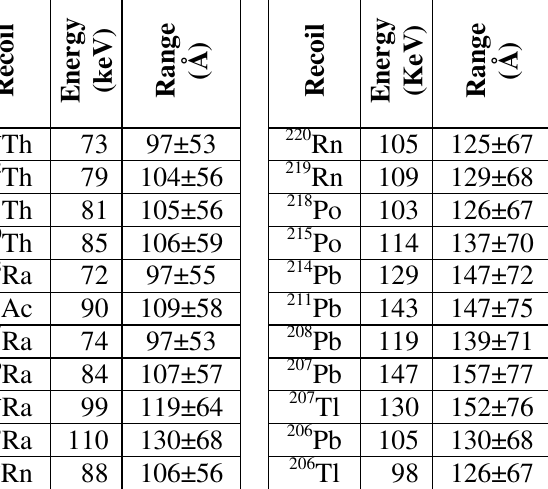
Table 2: Range of Daughter nuclei produced by α -decay. o ec R